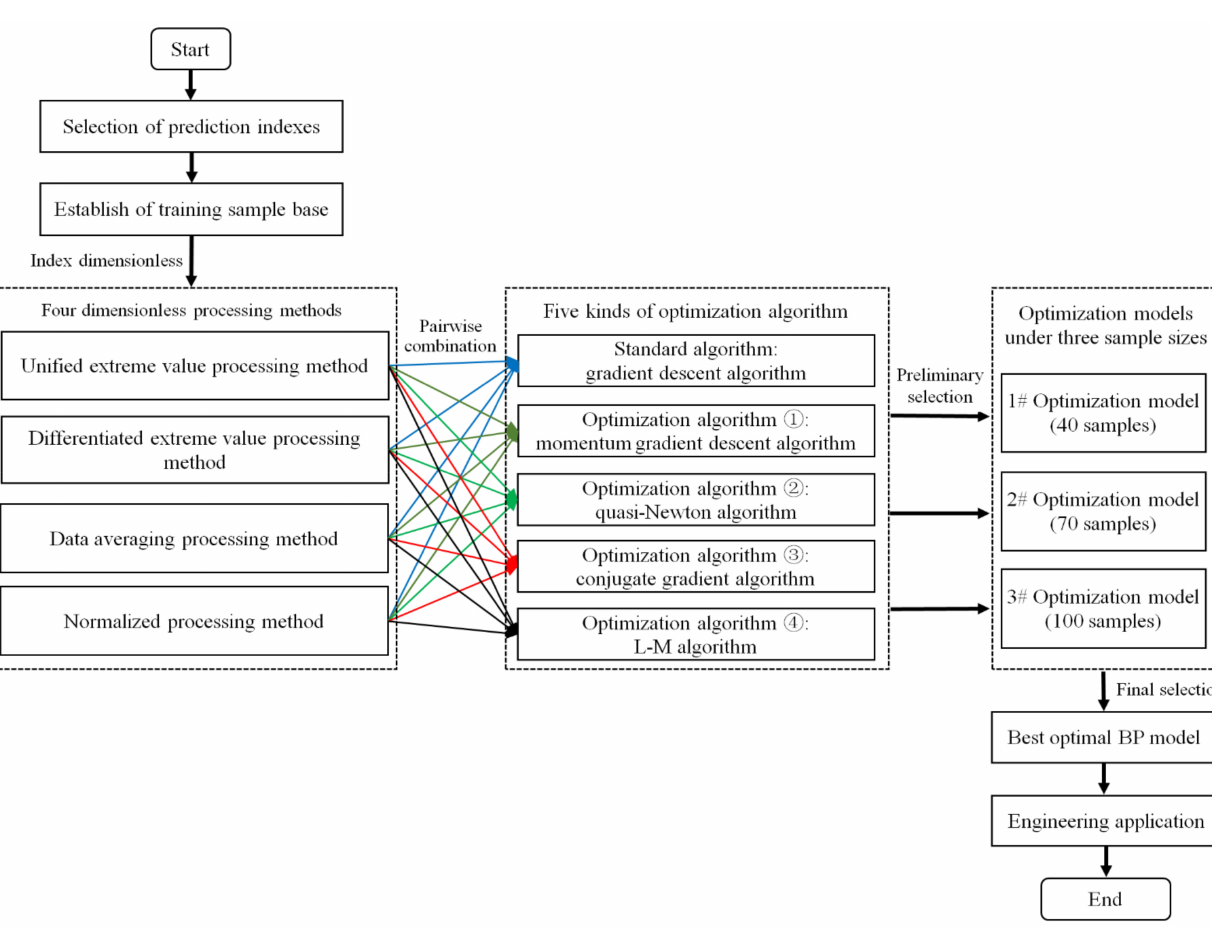
Figure 3. Flow chart of model